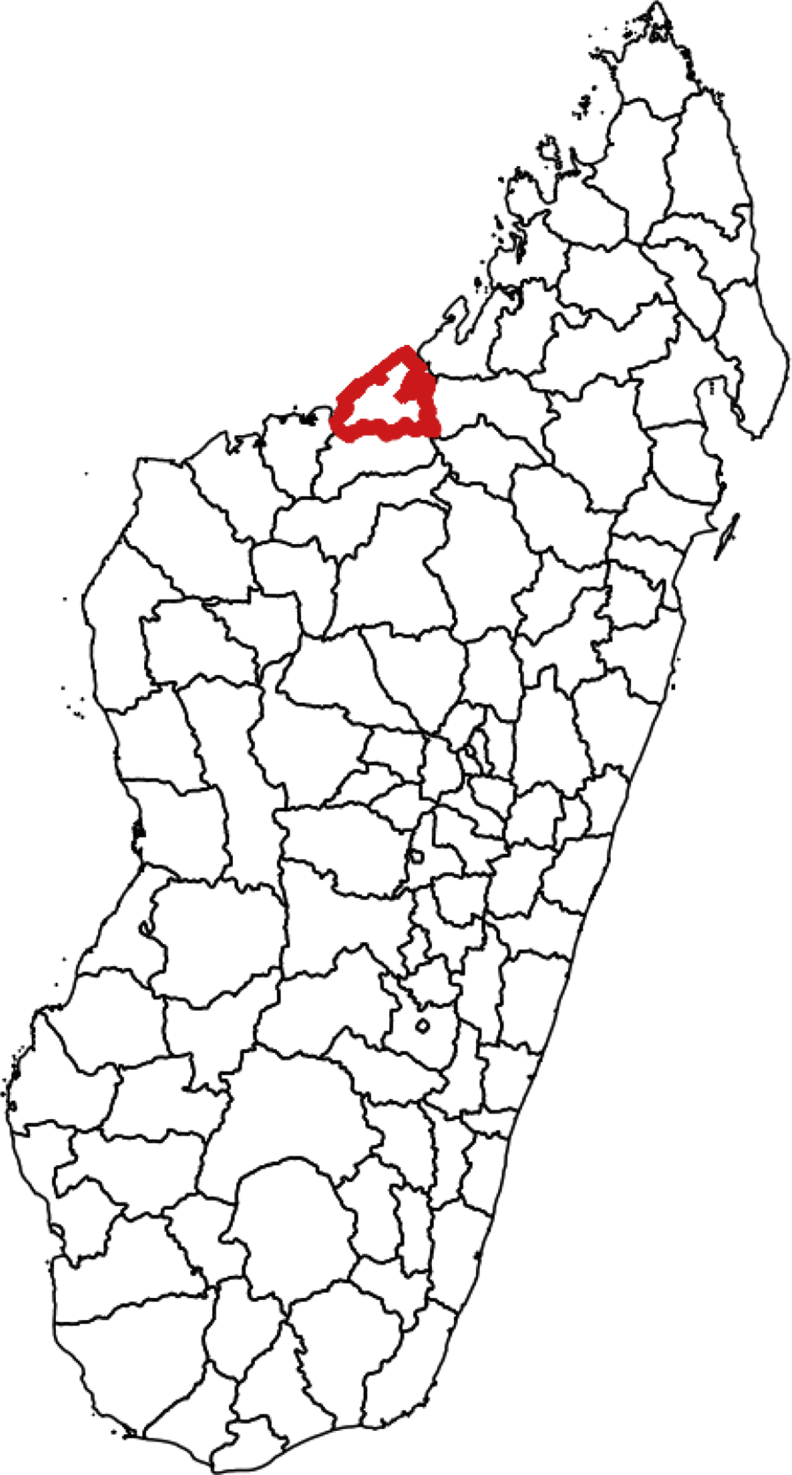
Mahajanga II District. Mahajanga II District is in the north-west region of Madagascar.